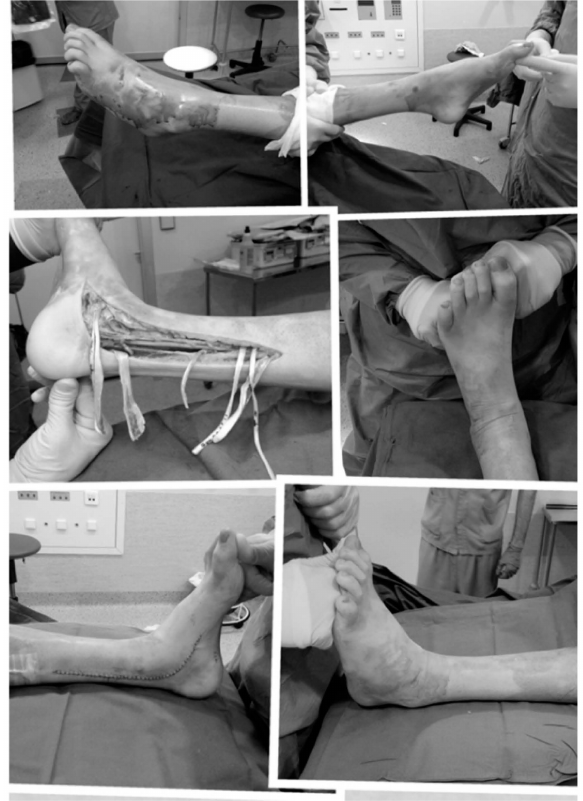
Figure 3. Feet surgery: ( Upper images ) Equinovarus feet before the surgery; ( Middle ) Left, surgery consisted in legs tendons transpositions; and right, the surgeon is testing the correction of equinovarus after the surgery; ( Down ) Equinovarus has been corrected in both